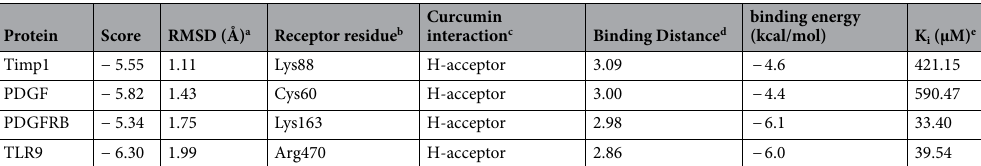
Table 2. Molecular interactions between curcumin and some proteins involved in liver fibrogenesis. a RMSD is the distance difference (Å) of the obtained docking orientation from the corresponding pose of the reference ligand; b In some cases, more than 1 residue participates in the binding process (Fig. 4). The residue mentioned here is the most prominent with the shortest binding distance and lowest binding energy; c In some cases, some other ionic and van der Waal bonds may exist. The one mentioned here is that corresponding to the lowest binding energy and shortest binding distance; d The binding distance (Å) between the reactive protein residue and the ligand binding atom; e The inhibition constant (K i ) is the concentration required to produce half maximum inhibition and was calculated from the resulting binding energy (ΔG) using the Gibb’s free energy equation: K i = exp(ΔG/RT), where R is the universal gas constant (1.985 × 10 −3 kcal mol −1 K −1 ) and T is the absolute temperature (298.15